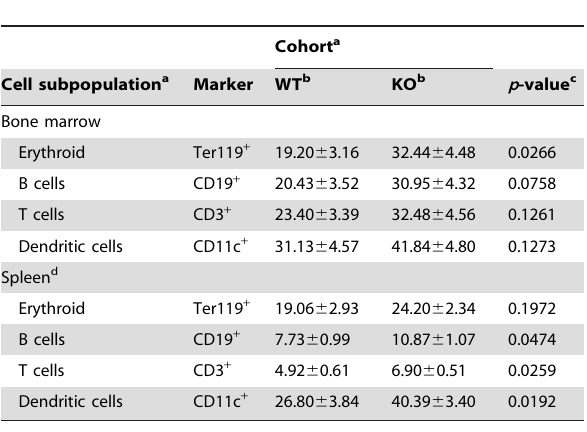
Table 1. Cellular FV infection of (B6 6 BALB/c)F 1